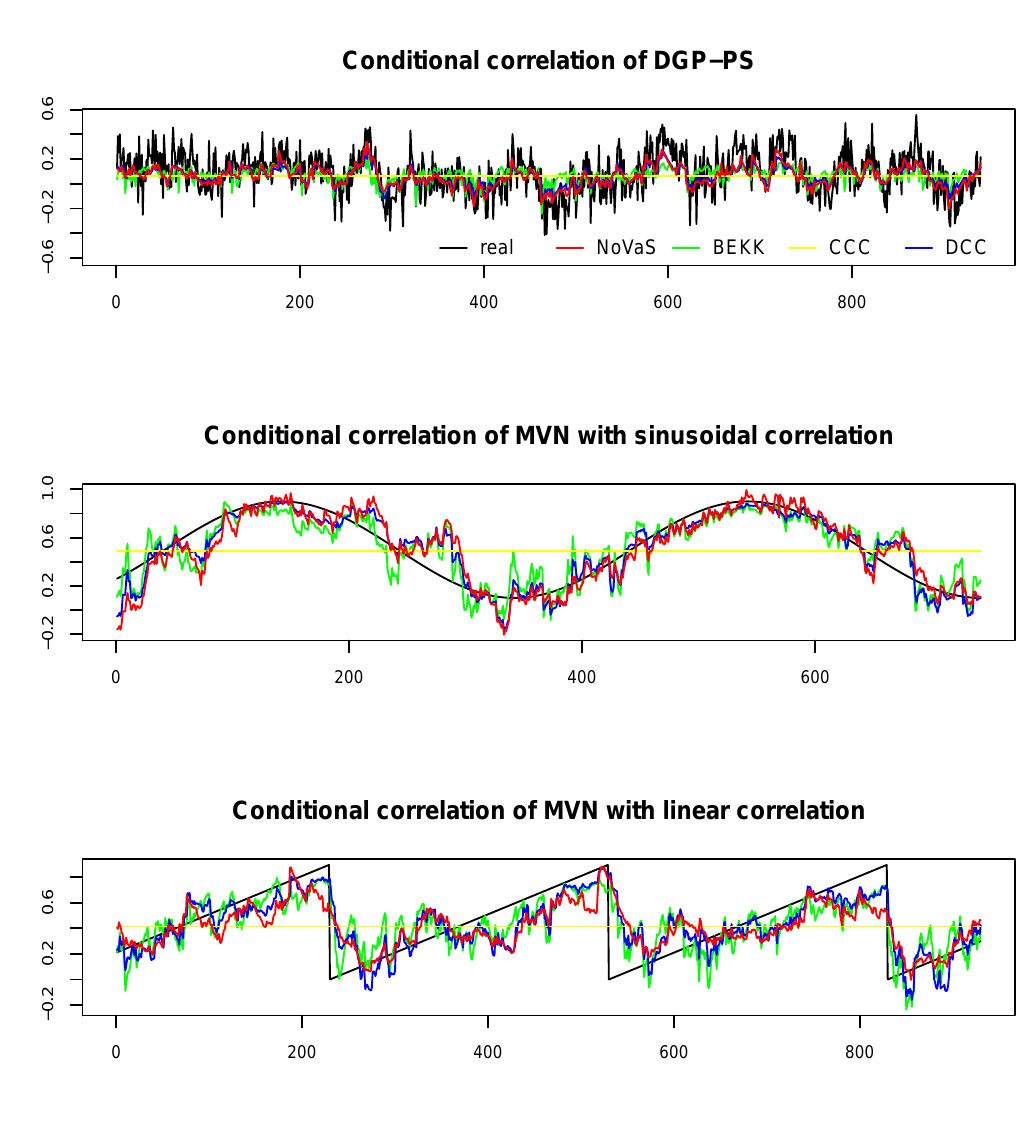
Figure 1. Comparison of the different methods to capture